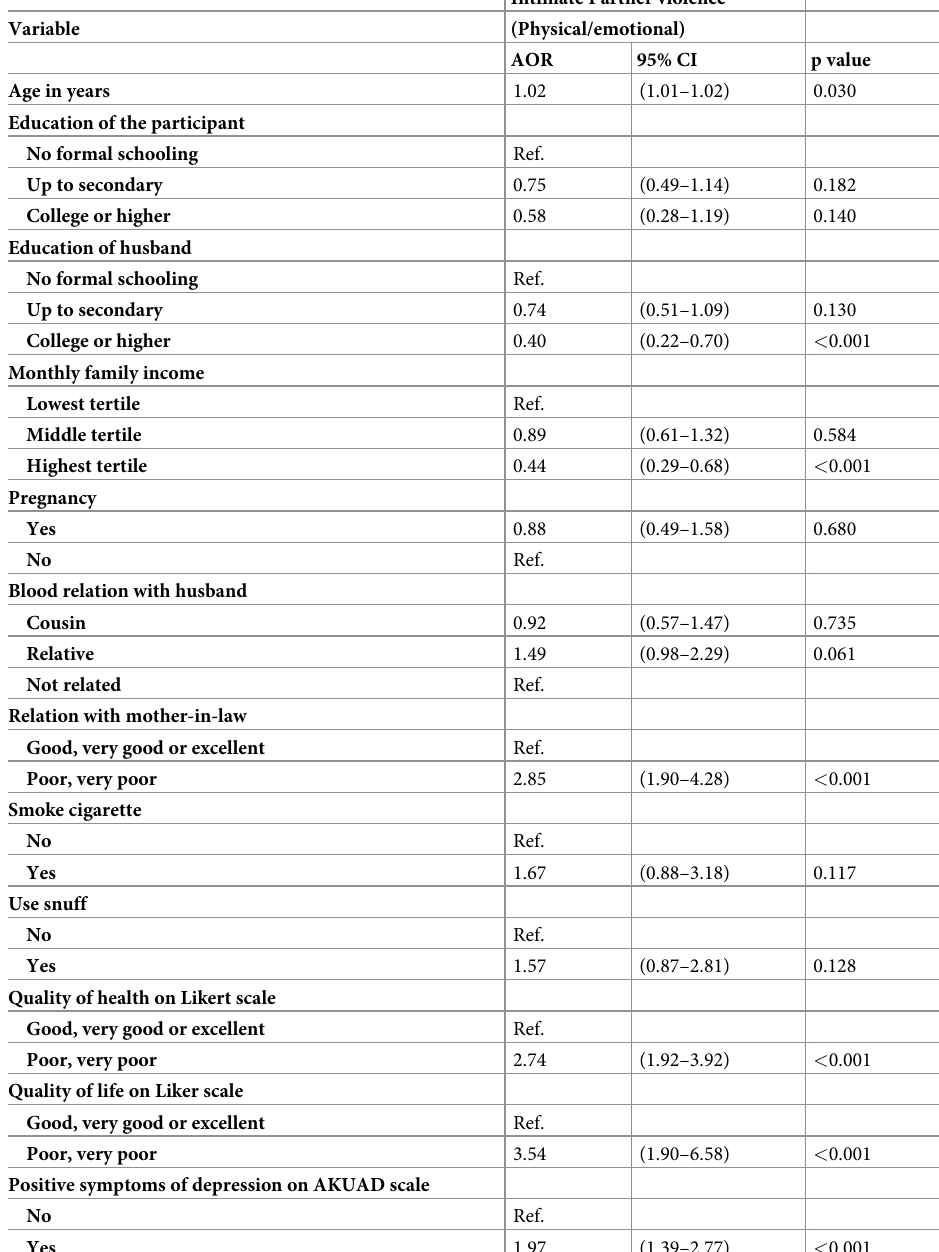
Table 2. Intimate partner violence in married women and its correlates in Himalayan Mountain Villages, Paki- stan: multivariate logistic regression